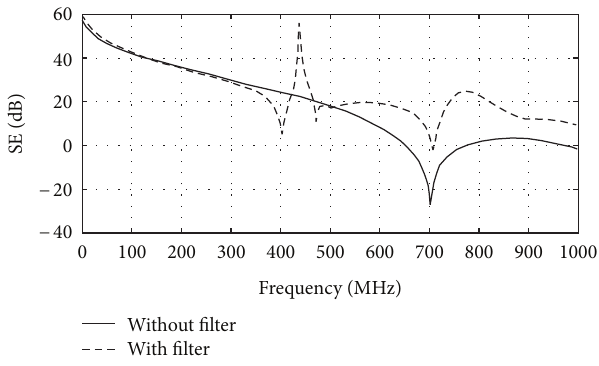
12 5 conducting × × ×